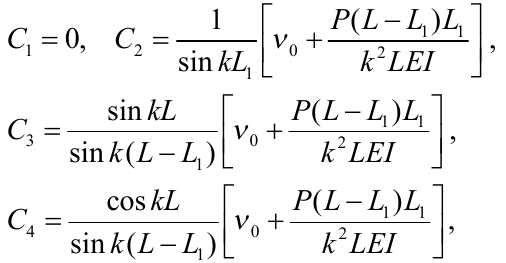
Fig 1. The scheme of elastic rod with a